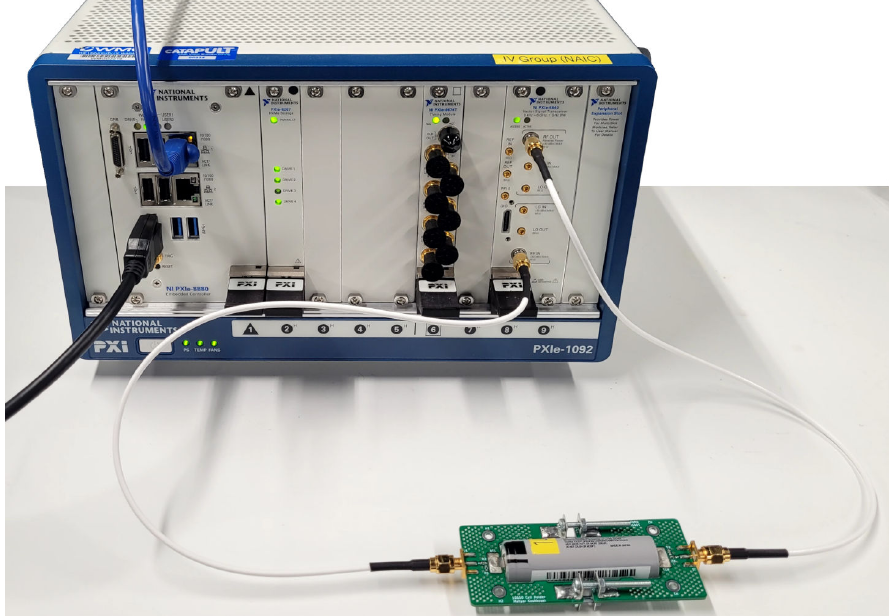
Figure 3. Photo of the Li-ion cell connected to the VST. The Li-ion cell is clamped within the bespoke cell holder as described in Section